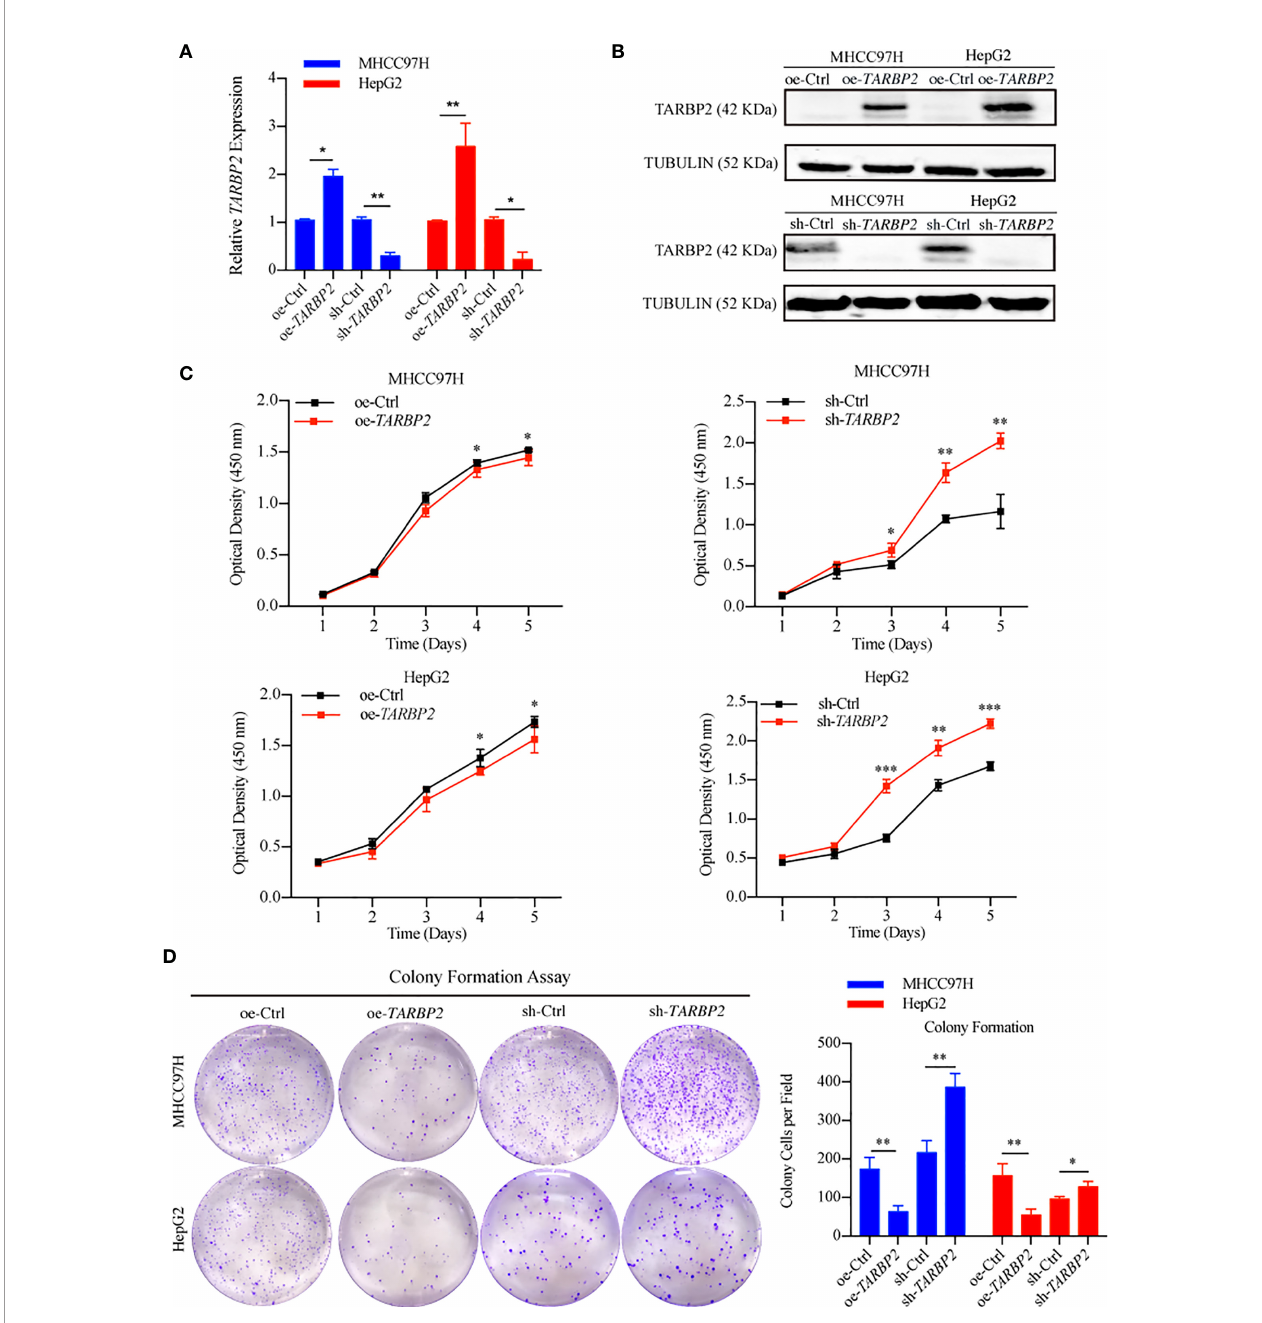
FIGURE 2 | TARBP2 affects proliferation of HCC cells. (A, B) The changes of mRNA and protein expression of TARBP2 compared with controls in HCC cell lines after transfection. (C, D) oe- TARBP2 HCC cells could inhibit proliferation, whereas sh- TARBP2 HCC cells could promote proliferation. *p-value < 0.05; **p-value < 0.01; ***p-value